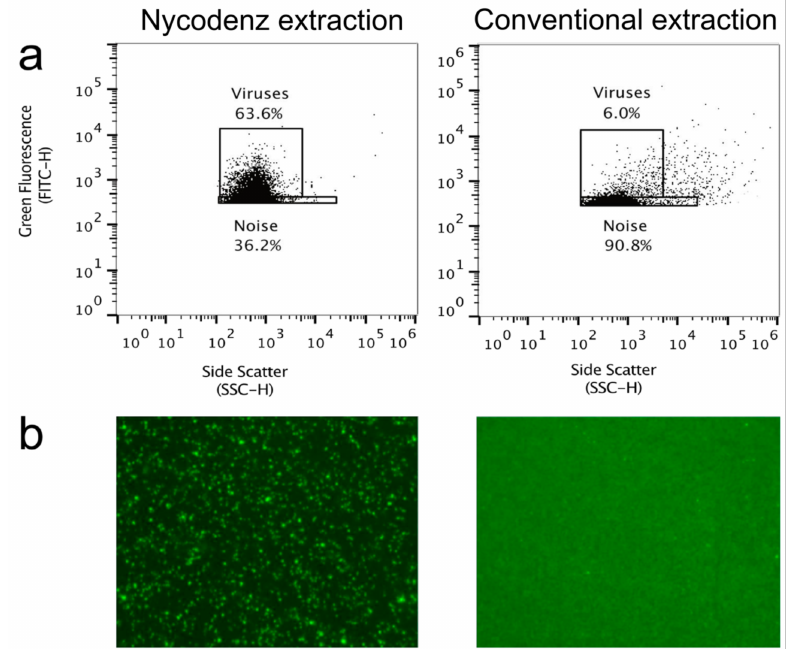
Figure 2. Example flow cytograms ( a ) and corresponding epifluorescence micrographs ( b ) of SYBR Green I stained virus particles extracted from sediment by the Nycodenz method (left) and conven- tional extraction method (right) [15]. Sediment was analyzed on the Attune NxT at